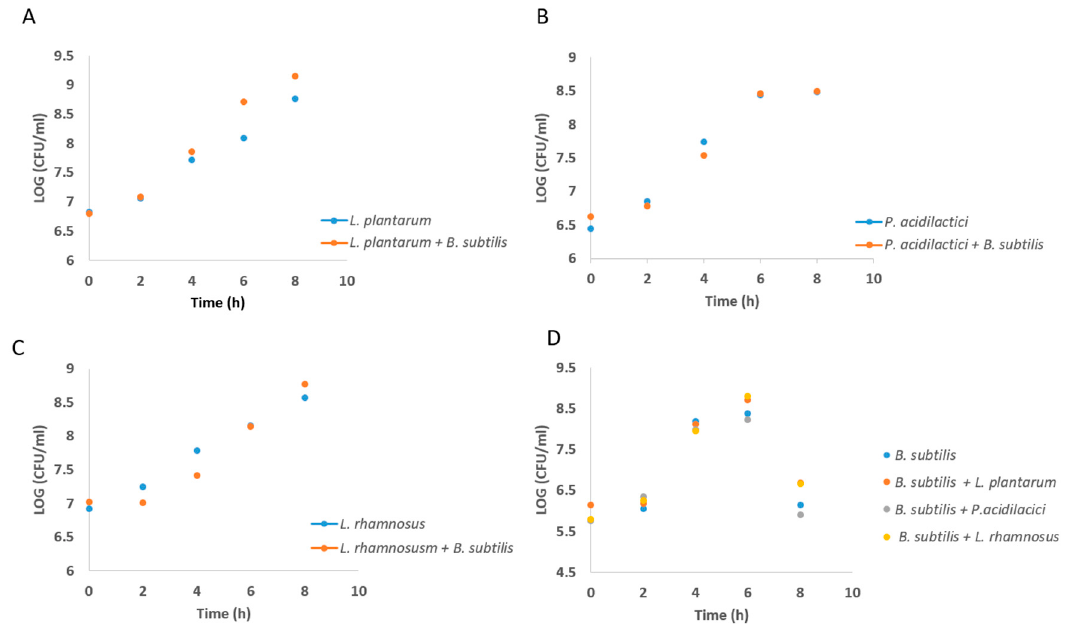
Figure 2. Co-culture growth of B. subtilis with the LAB bacteria does not influence growth rate. Growth curve analysis of LAB cells in presence or absence of B. subtilis . The blue line represents the growth rate of a single-species culture of LAB, whereas the orange line represents the growth rate of ( A ) L. plantarum, ( B ) P. acidilactici , and ( C ) L. rhamnosus in co-culture with B. subtilis . ( D ) Growth curve of B. subtilis cells in the presence of LAB species compared to single culture. The cells were analyzed during growth for 8 h in 37 °C, 150 rpm.